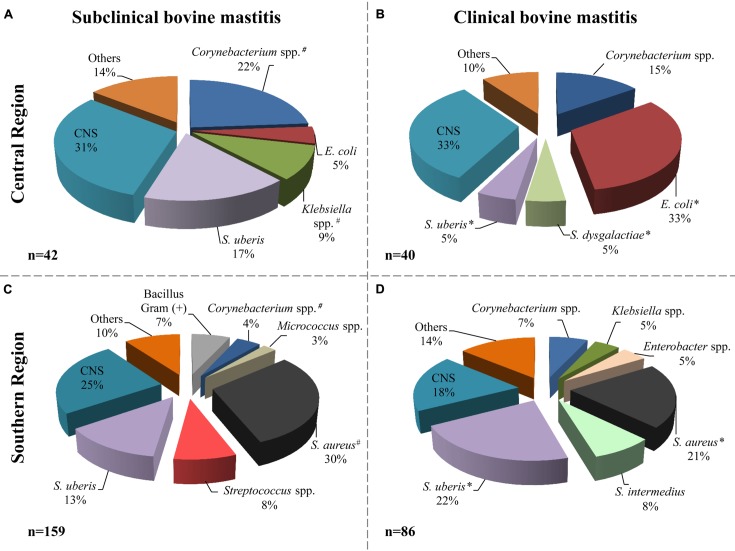
Bacterial species distribution isolated from milk samples. Microorganisms identified in subclinical (A, central; C, southern) and clinical (B, central; D, southern) mastitis milk samples. The central region includes 82 isolates and the southern region includes 245 isolates. The label “Others” includes microorganisms isolated with frequency ≤2% of the total. # indicate that the frequency of isolation of microorganisms, from subclinical mastitis, between the regions is significantly different (p ≤ 0.05). ∗ indicate that the frequency of isolation of microorganisms, from clinical mastitis, between the regions is significantly different (p ≤ 0.05). Others included: Enterobacter cloacae, Enterococcus faecium, Streptococcus spp., Bacillus, non-fermenting Bacillus, Aeromona, Yersinia sp., Serratia sp., and Candida spp.